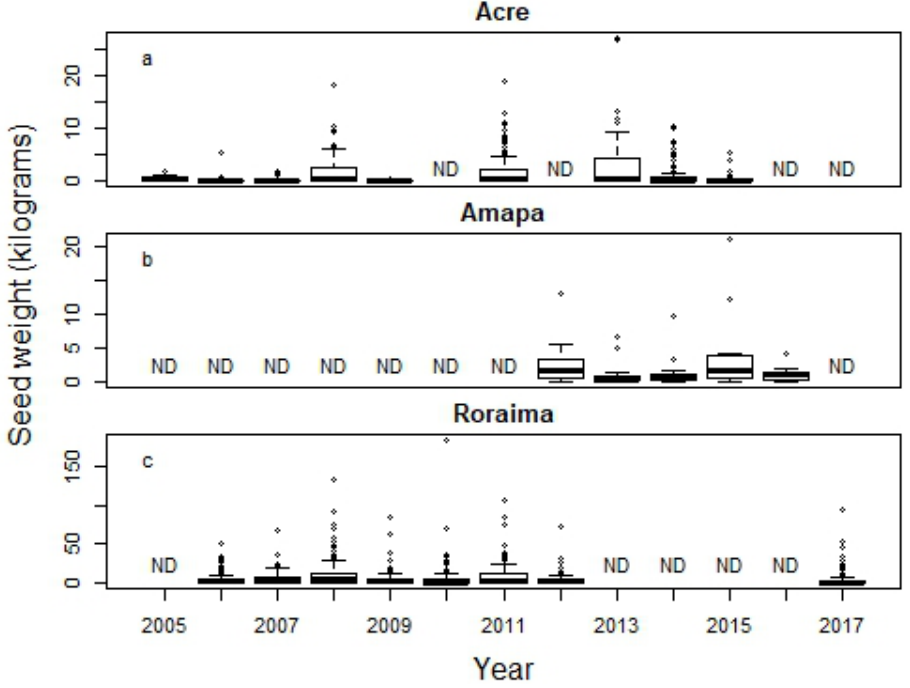
Figure 1. Boxplots of Carapa guianensis seed production (kilograms) by year are shown for the three study regions in the Brazilian Amazon: ( a ) Acre, ( b ) Amapá, and ( c ) Roraima. ND indicate years for which no data were collected at a specific site.